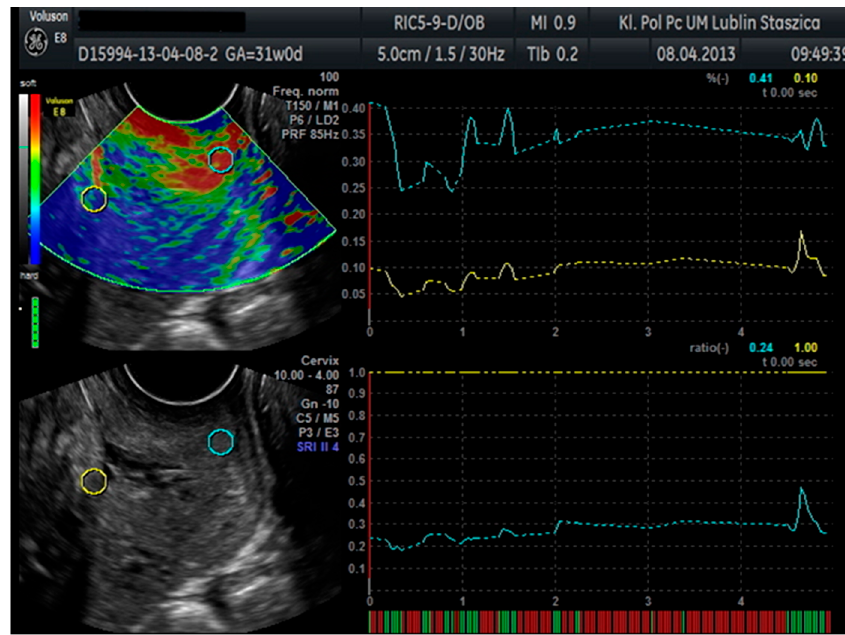
Figure 1. Cervical elastographic evaluation in the Elastography Analysis program. -own source. The transducer receives two sets of radiofrequency signals: before and after squeezing the cervix, and the amount of shift in the tissue is estimated from the waveform difference. Tissue rate versus distance from the transducer is calculated for all image points. The rate of change values are known as strain values and are displayed in a variety of colors ranging from red to yellow, green to blue for soft and hard tissues. Tissues marked in red are considered to be the most flexible tissues, while tissues with the least elasticity are marked in blue (Figure 2).